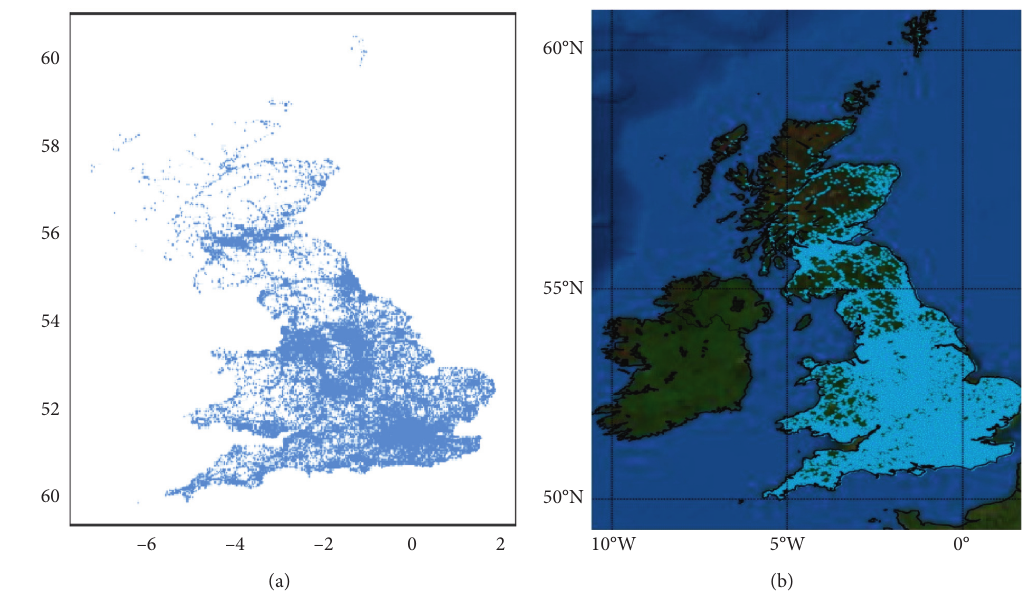
Figure 2: (a) The longitude and latitude map of the accident point and (b) the map-matching graph.